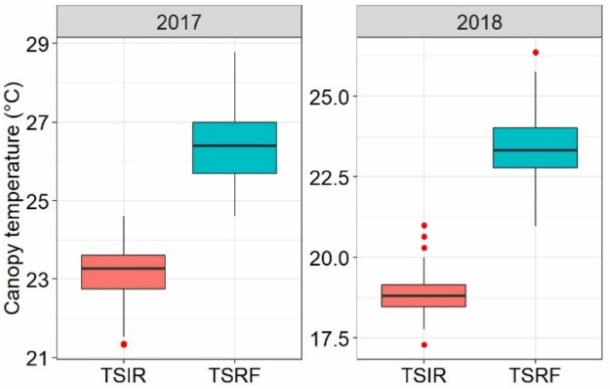
Figure 1. Boxplot of the canopy temperature ( ◦ C) measured at heading stage at Tessaout under irrigated (TSIR) and rainfed (TSRF) conditions during two consecutive seasons of 2016–2017 and 2017–2018.